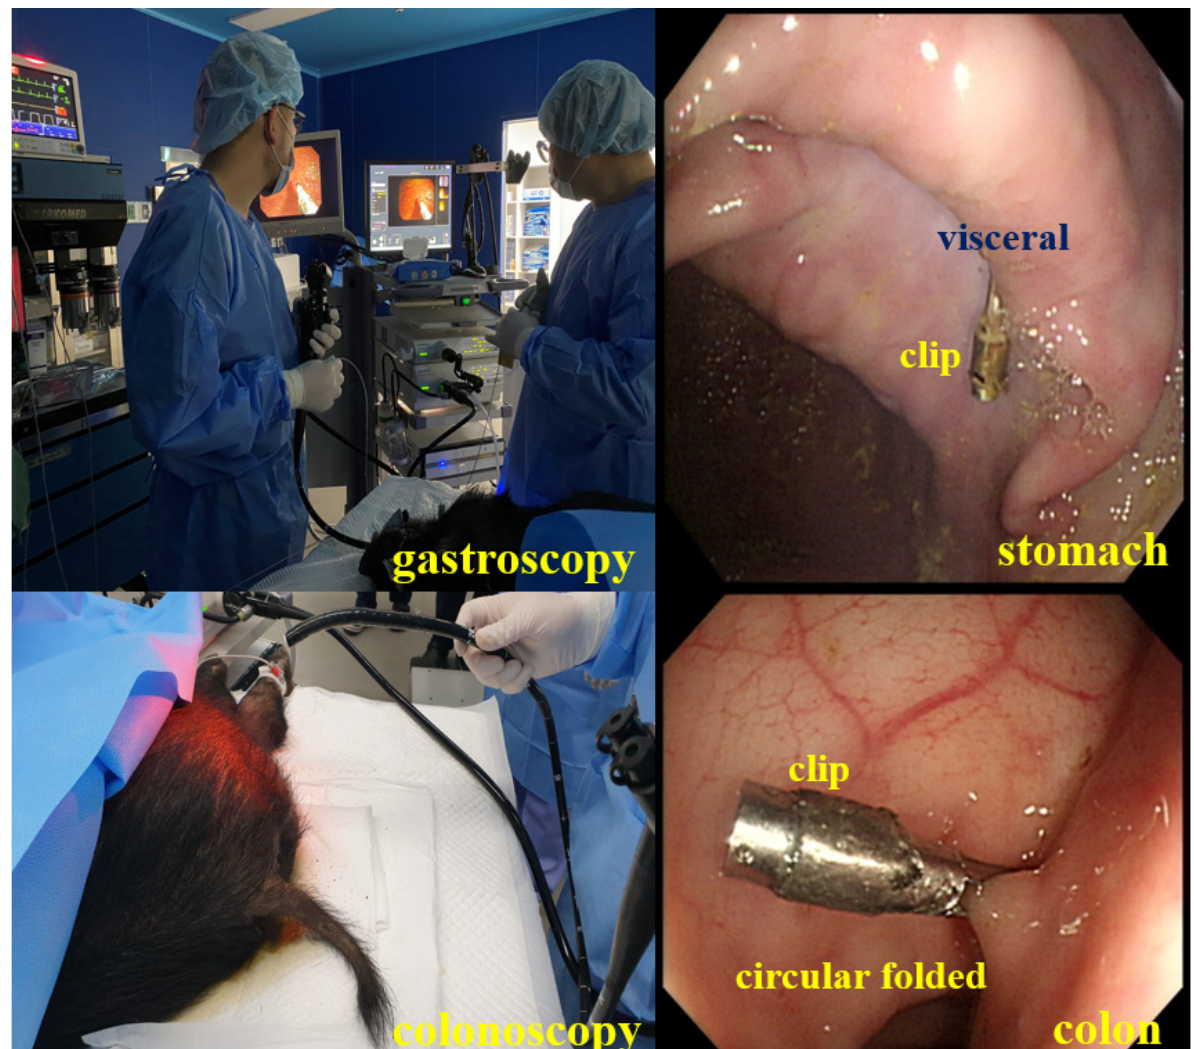
Figure 14. Clip set installed in the mucosa of colon and stomach using colonoscope and endoscope, respectively.